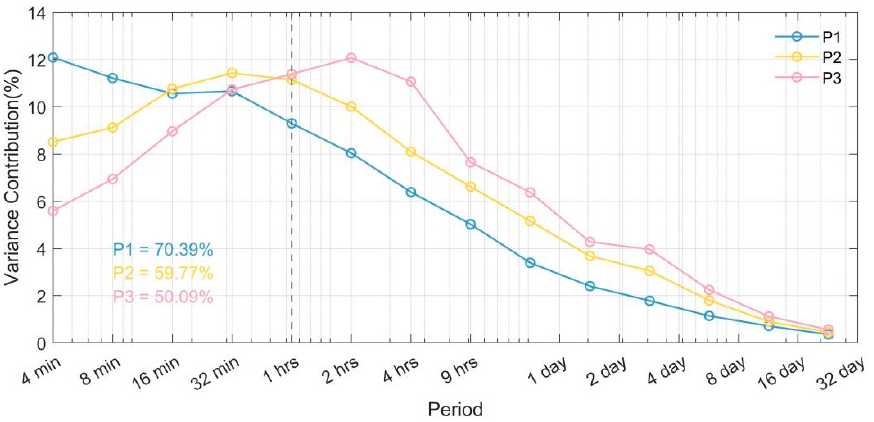
Figure 10. This is similar to Figure 3a but for 1 min rainfalls under the synoptic patterns of P1, P2, and P3. The X -axis represents the range of time scales from minutes to 32 days. The Y -axis is the wavelet variance at each time scale in percentages of the accumulated rainfall expectation.